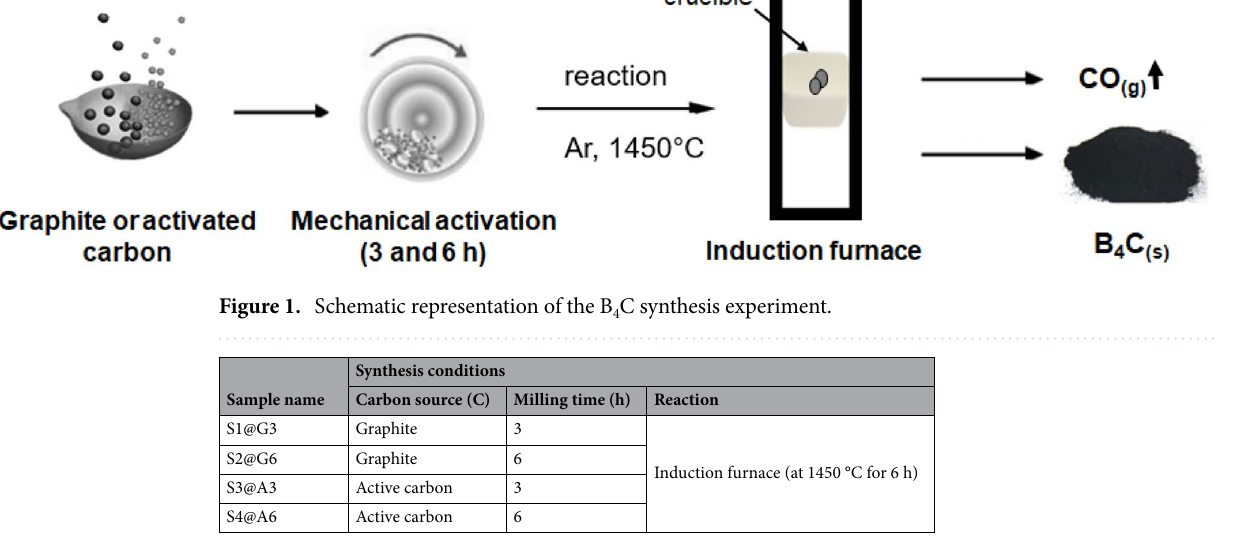
Table 1. B 4 C powders synthesized using anhydrous boron oxide (B 2 O 3 ) and varying carbon (C)